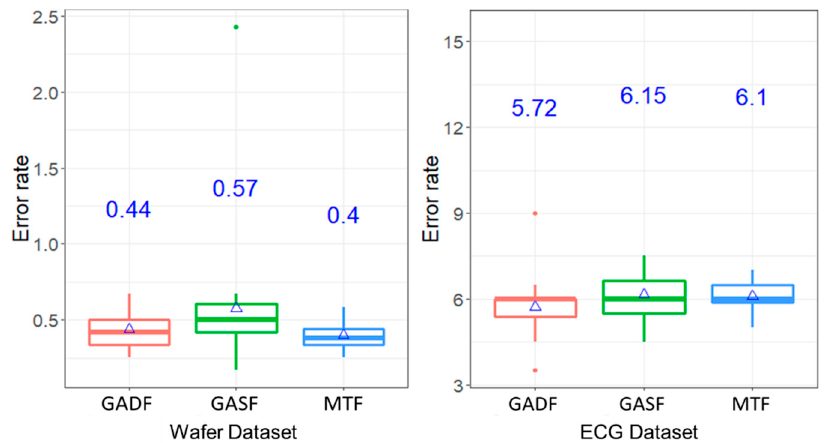
Figure 5. The boxplot of error rates of classification by using RGB images as inputs by GADF, Gramian Angular Summation Field (GASF), and MTF transformation methods (Wafer and electrocardiogram (ECG) database).